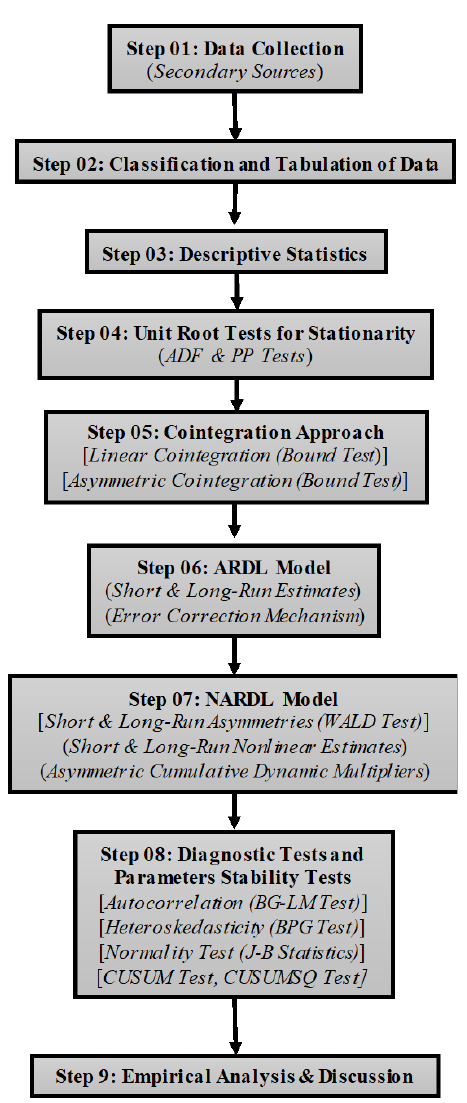
Figure 4. Research framework. Source: Authors’ compilation.